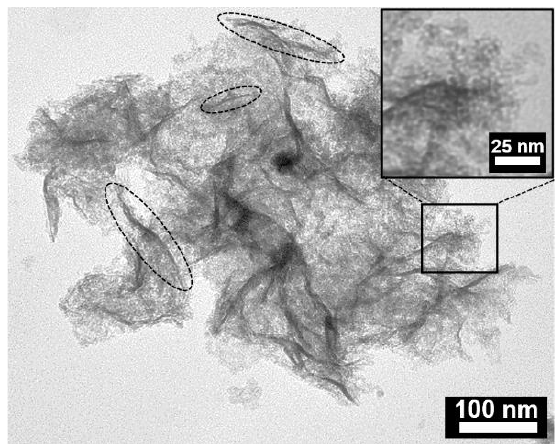
Figure 2. TEM images of the Mn-nanozyme. Some MnO x needles are marked. In the inset, an enlarged image is observed in which both the mesoporous nature of the Si-rich nanoparticles and their small size can be seen.